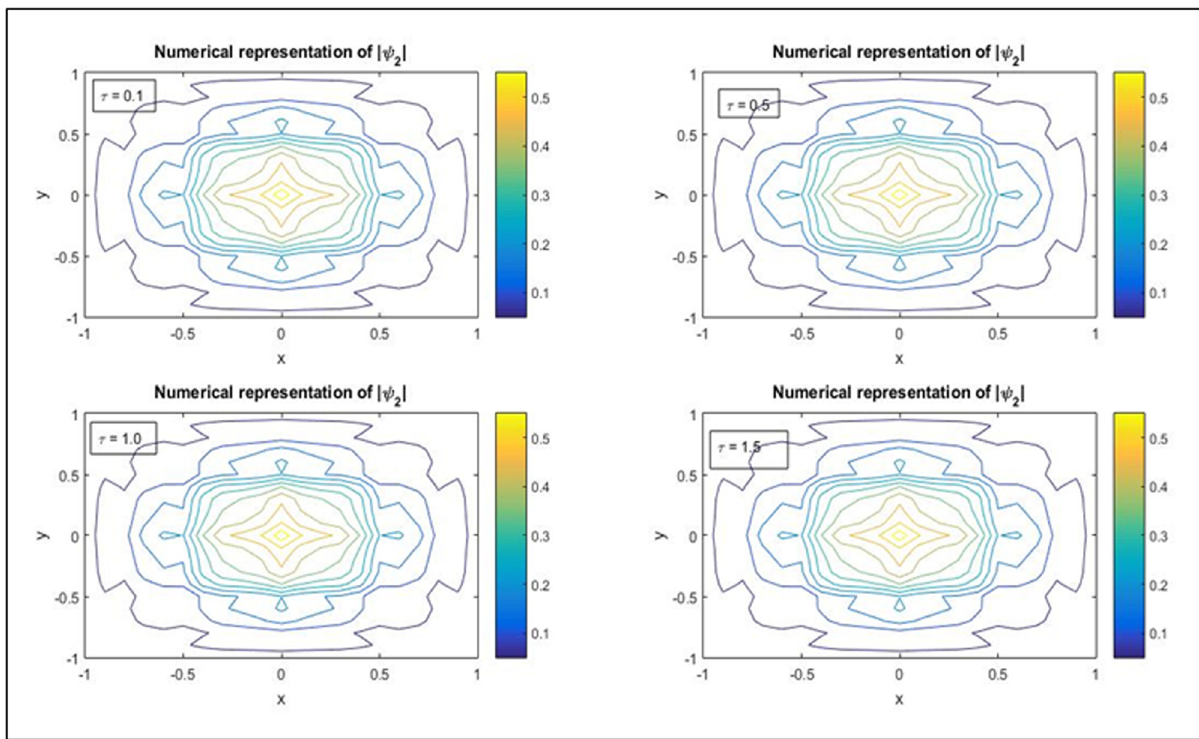
Figure 16: Graphical representation of numerical solution of second - wave amplitude at = t 1 for parameters, = N 21 , = t Δ 0.0001 , and = α 0.1 and for di ff erent values of tension parameter τ .